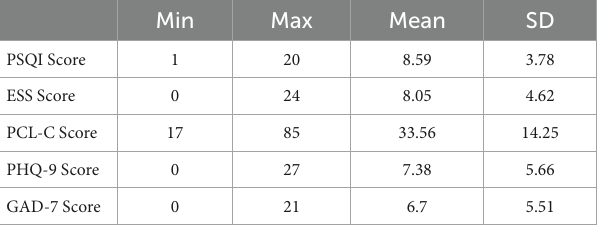
TABLE 2 PSQI (sleep quality), ESS (daytime sleepiness), PCL-C (PTSD symptoms), PHQ-9 (depression), GAD-7 (anxiety) scores within the sample ( N = 319).